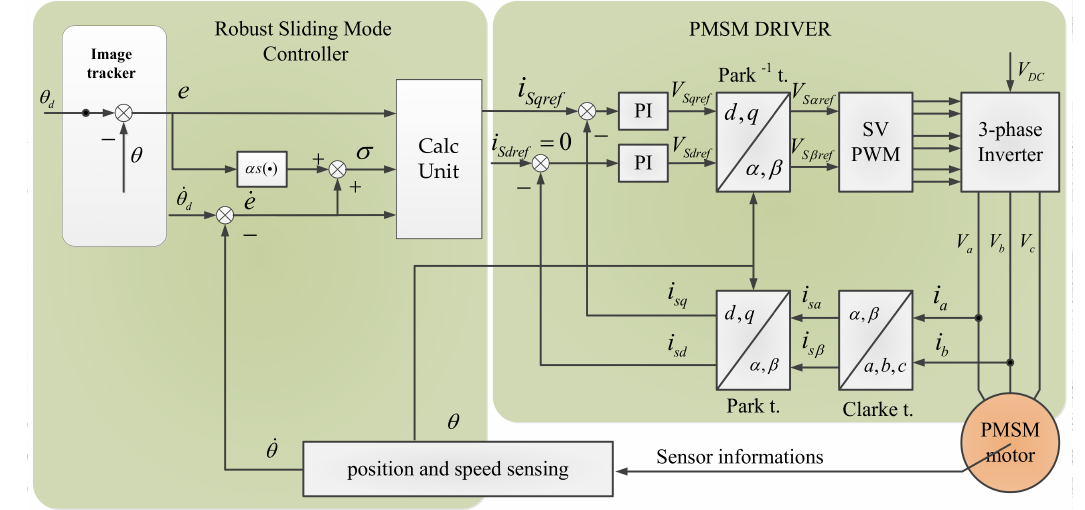
Figure 2. Block diagram of robust sliding mode control.